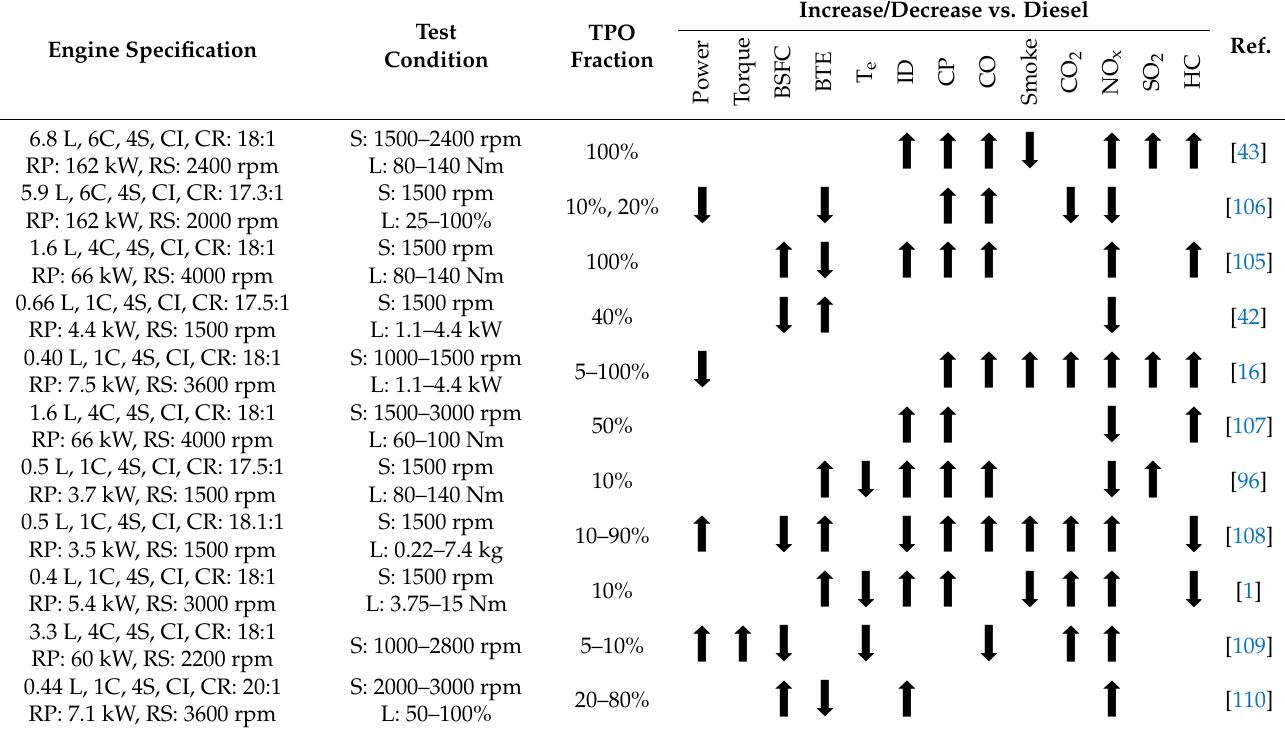
Table 4. Diesel engine emission and performance with TPO.